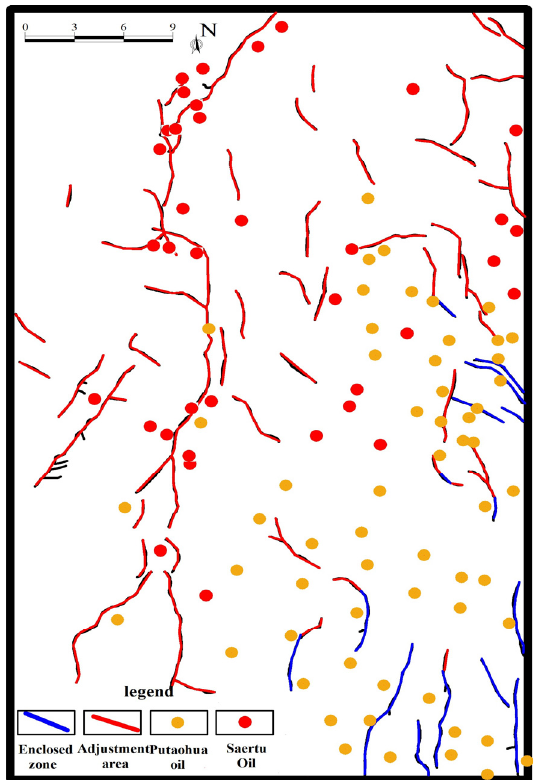
Figure 8. Distribution of migrated hydrocarbon fluid at the Saertu reservoir from the Putaohua reservoir in the Bayan Chagan Area.